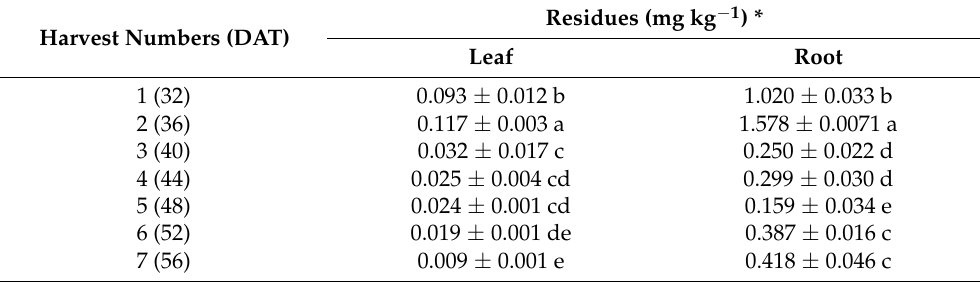
Table 3. Diazinon residues in leaf and root samples during the harvest.